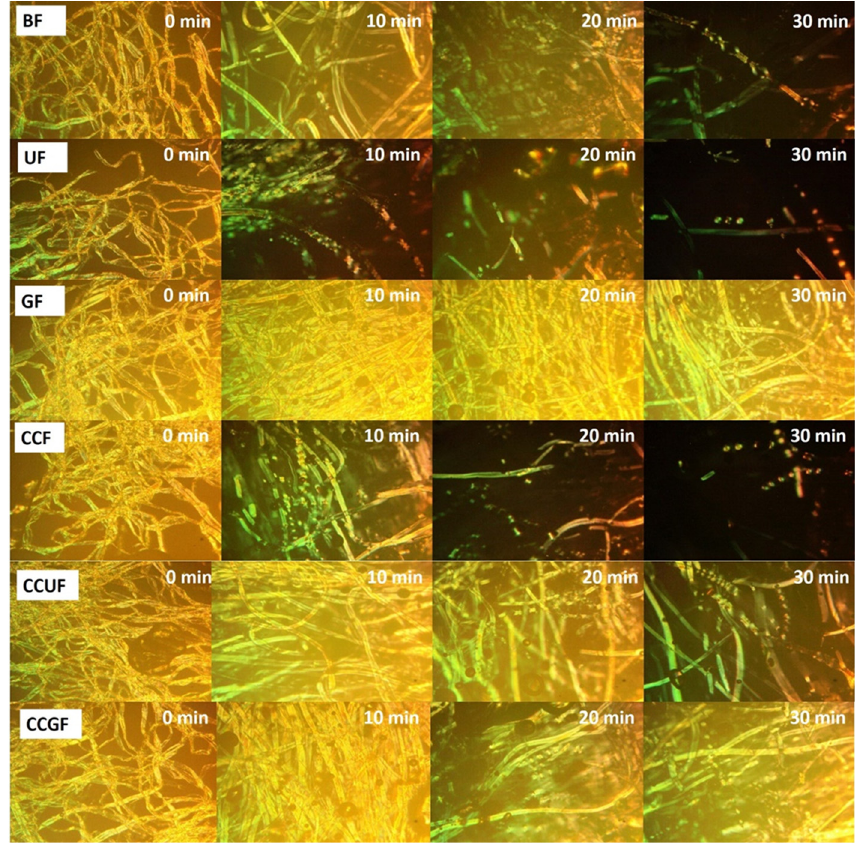
Figure 7. Polarizing microscope observations of the cellulose solubility in AMIMCl solution at 80 °C with 400X magnification with or without additives at 0, 10, 20, and 30 min respectively: the undissolved cellulose appeared as a bright spot in the visual field, and the dissolved cellulose cannot be observed (black).